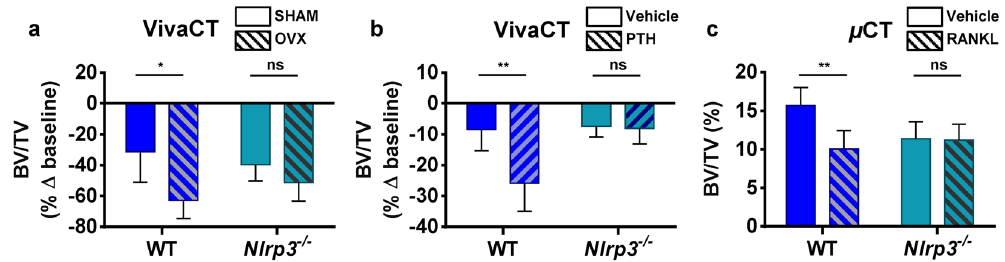
Figure 5. Osteopenia associated with high bone turnover is reduced in mice lacking NLRP3. ( a ) VivaCT analysis was performed on the femurs of 4-month old WT and Nlrp3 − / − female mice before and at 8 weeks after OVX or sham surgery. ( b ) VivaCT analysis of 4-month old WT and Nlrp3 − / − male mice exposed to PTH (80 μ g/ kg/day) or vehicle for 2 weeks via osmotic pumps. Data are means ± SD of the percentage of changes relative to baseline (before surgery or treatment) of 4–6 mice/group; ( a ) * p = 0.0111; ( b ) ** p = 0.0017. ( c ) Post-mortem µ CT scan was performed on the femurs from 3-month old WT and Nlrp3 − / − male mice exposed to acute RANKL treatment (1 µ g/kg once a day, for 2 days). Data are means ± SD of 4–7 mice/group; ** p =